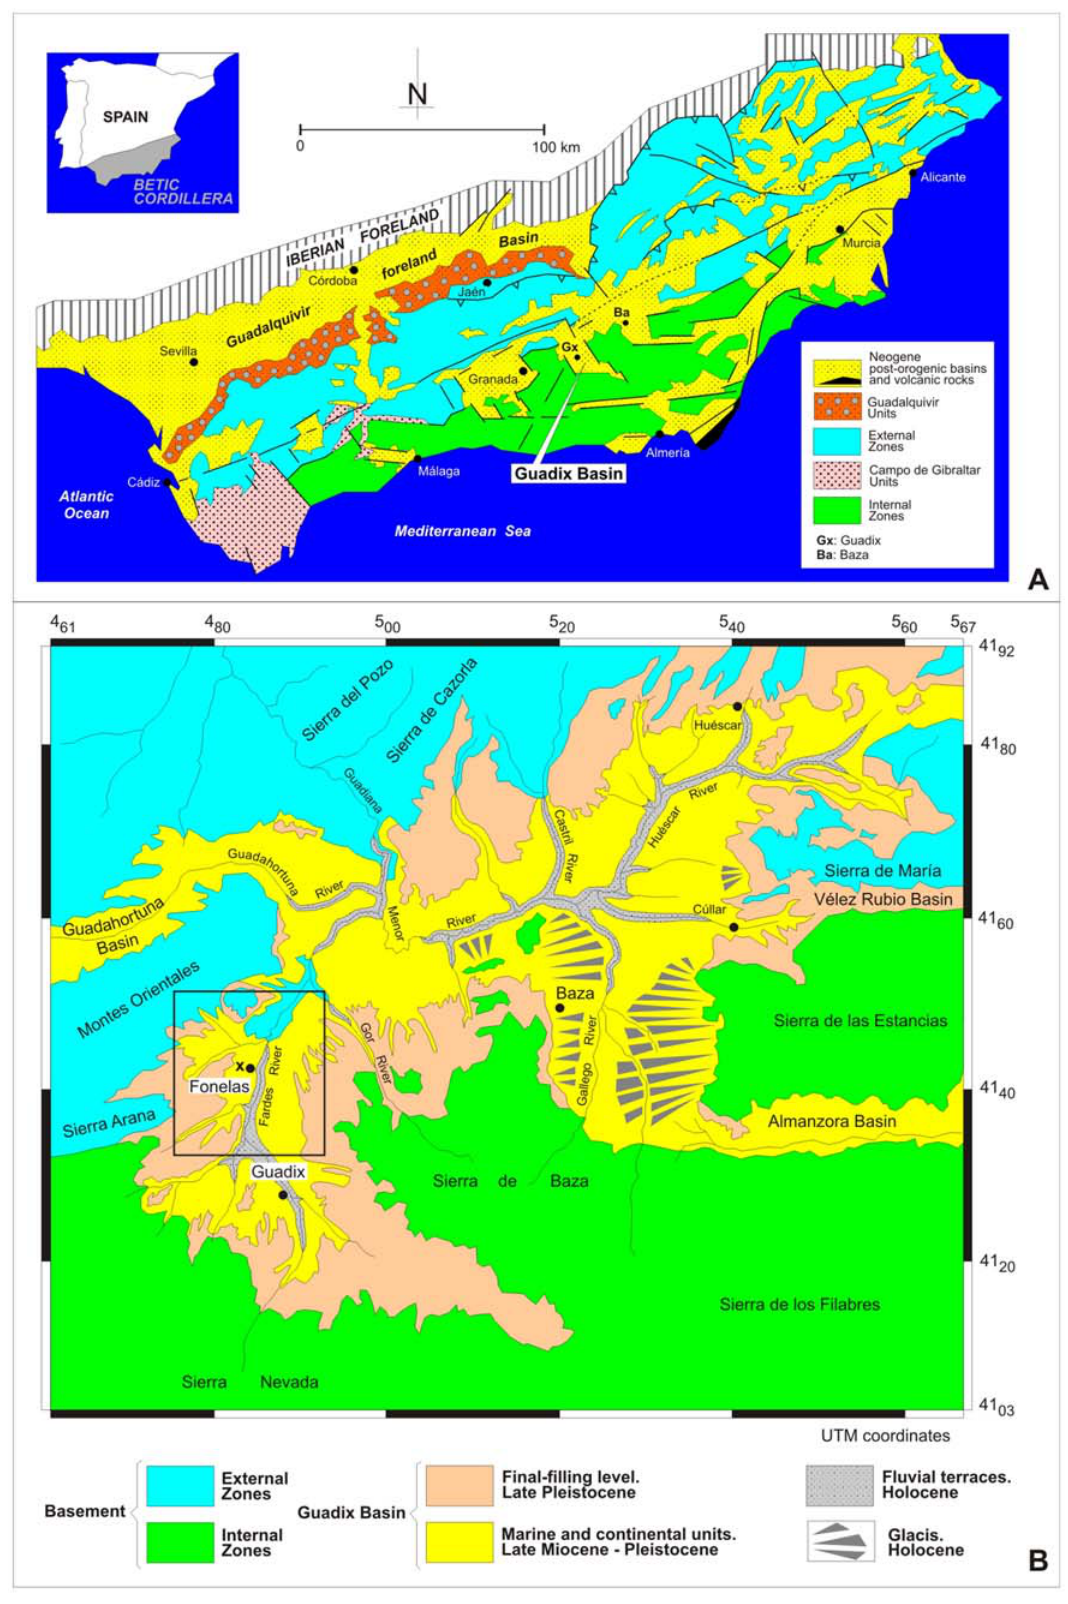
Figure 1. Geological maps of the Betic Cordillera in southern Spain. A. Location of the Guadix Basin in the geologic units of the Betic Cordillera. B. Simplified geological map of the basin, X marks the position of the FP-1 site, in the west slopes of the River Fardes valley (the box delimits the fieldwork area of the Fonelas Project 2001–2007; see Figure S1) (modified after 27).